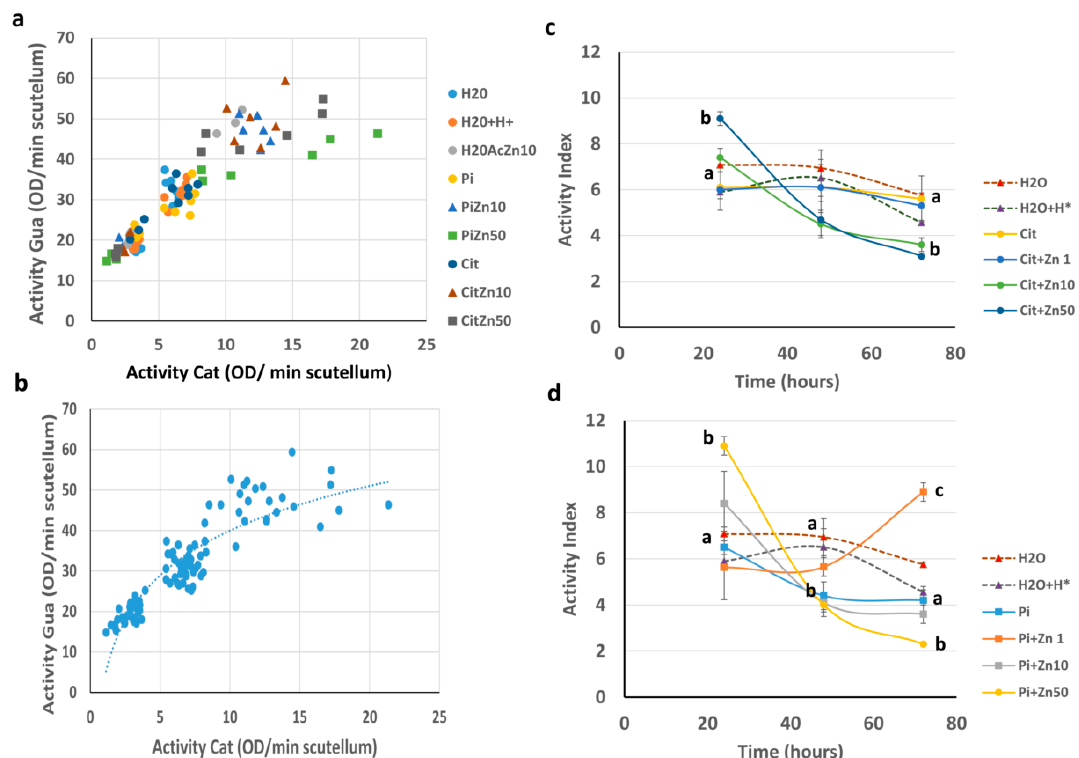
Figure 6. Peroxidase activity index in scutellum. ( a ) Relationship between the activity of POD-Cat vs. POD-Gua for the different experimental conditions during germination. ( b ) The dotted line indicates the regression model, which was fitted to a logarithmic relationship with the equation y = 15.933 ln (x) + 3.2831, with R 2 = 0.8114. ( c , d ) Relationship between activity index (AI) values for the activity of POD-Gua/activity of POD-Cat for each experimental condition during the germination. ( c ), ZnCl 2 in citrate buffer; and ( d ), ZnCl 2 in phosphate buffer. The graph shows the mean ± SE with 3 to 6 independent assays. ANOVA was performed, followed by the Tukey–Kramer multiple comparison test, with p < 0.05 representing significance. Letters that are the same indicate similar variations, and different letters indicate significant differences at each imbibition